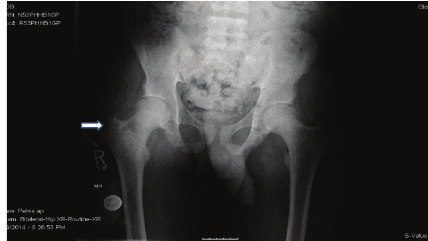
Figure 8: Bony resorption of greater trochanters of both femoral bones typical of untreated hyperparathyroid bone disease at the locations of the patient’s pain (denoted by arrow).